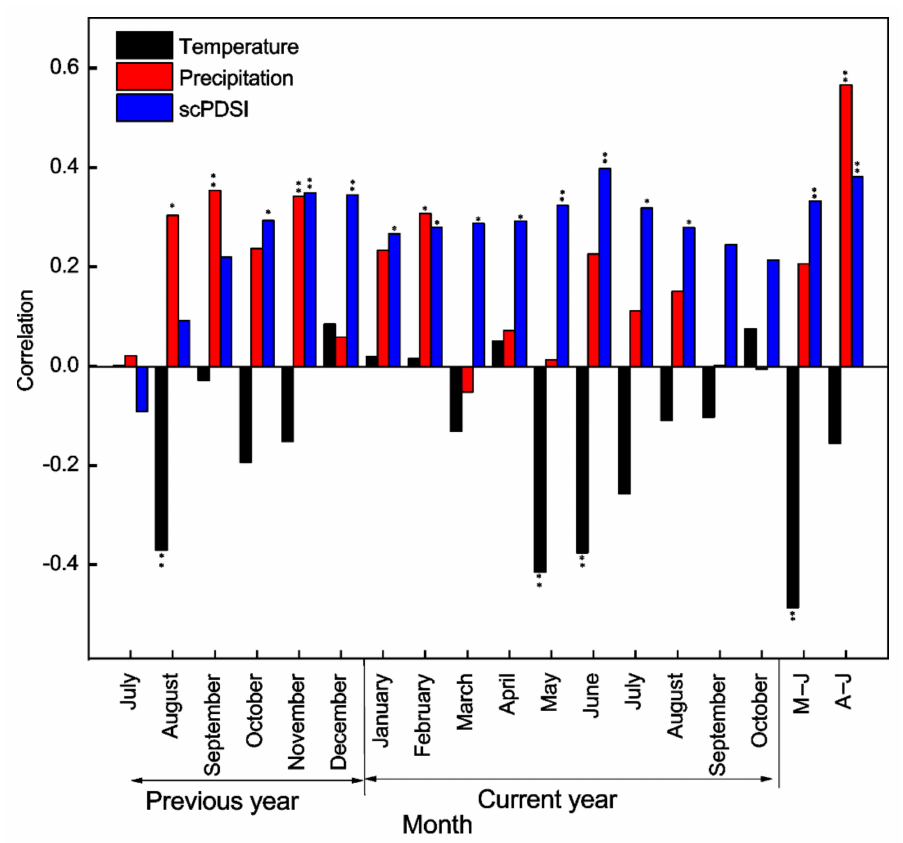
Figure 4. Correlations between tree-ring RES chronology and monthly mean temperature and scPDSI, monthly total precipitation.* and ** represent significance at the 95 and 99% confidence limits; M–J: May to June; A–J: August of the previous year to June of the current